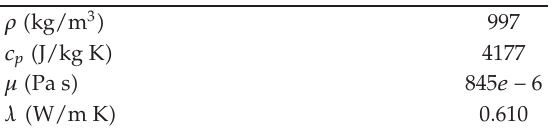
Table 2: Properties of